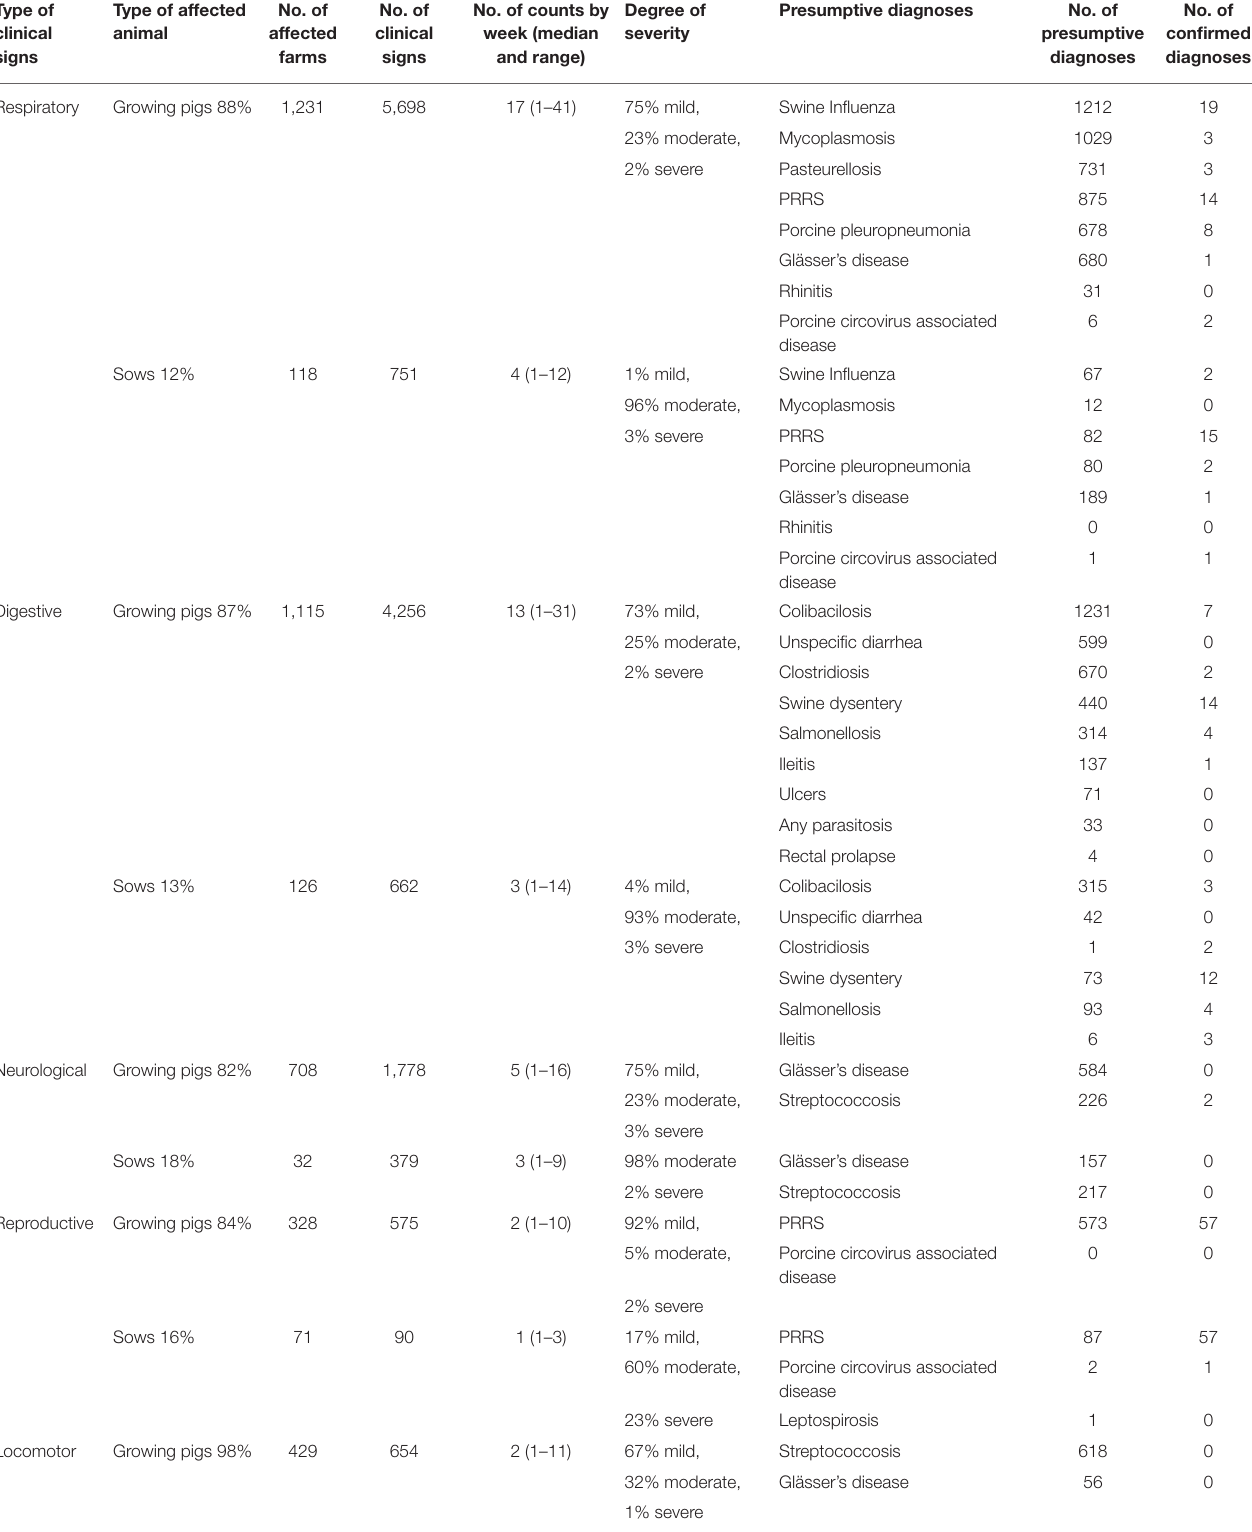
TABLE 2 | Summary of clinical signs and presumptive diagnoses differentiating growing pigs and sows (period: January, 2012–March, 2018). Type of